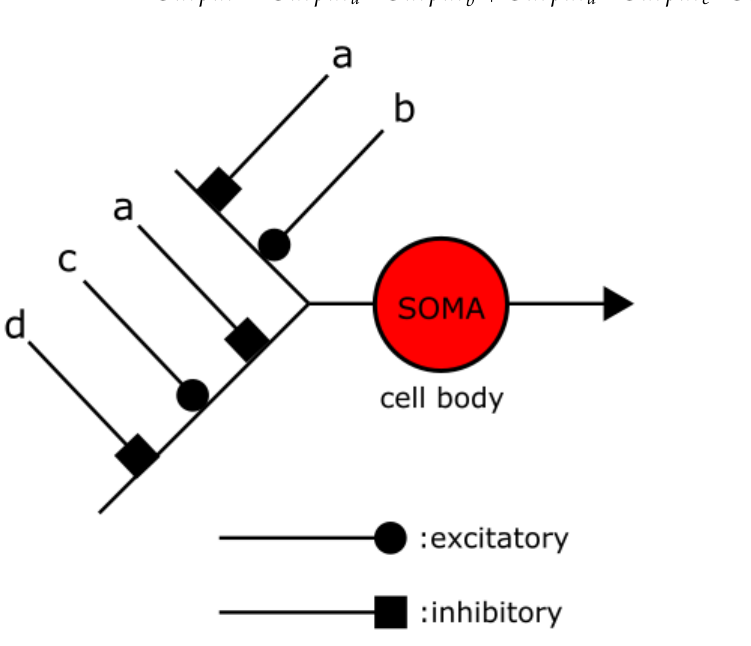
Figure 2. An advanced model used for describing the nonlinear relationship in the dendrite with multiple branches. The a, b, c, d here stand for the different